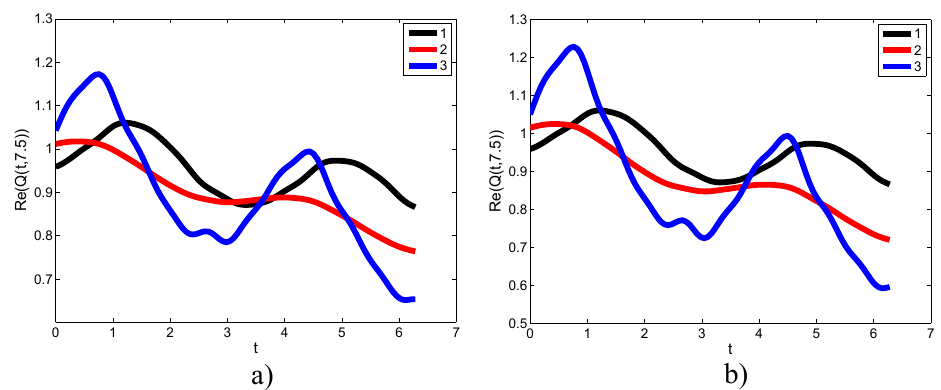
Figure 7. Plots of Re ( Q ( t ,7.5 )) for the models including H at selected values of d and H in comparison with the solution for the Newtonian model ( a ) d = 4, H = 0.47. ( b ) d = 6, H = 0.45. Black line— Newtonian model; blue line—Modified Yeleswarapu model; red line—Quemada